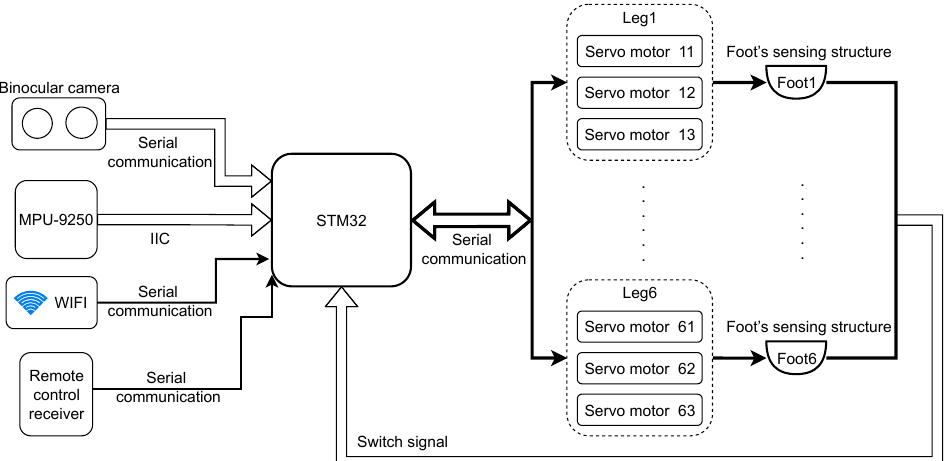
Figure 3. The hexapod robot’s electrical